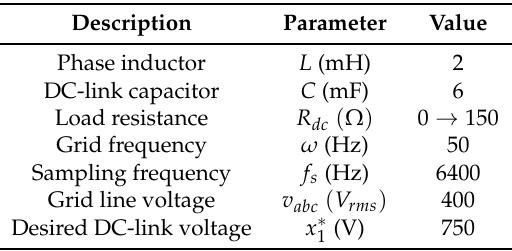
Table 2. System parameters.